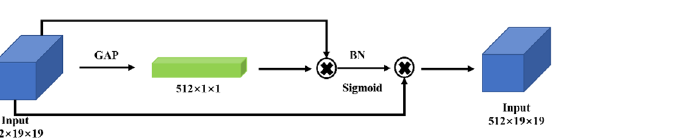
Figure 7. BNCA module. The attention mechanism is applied to each channel through the Global Average Pooling and sigmoid functions, and the size of the feature layer is not changed in the